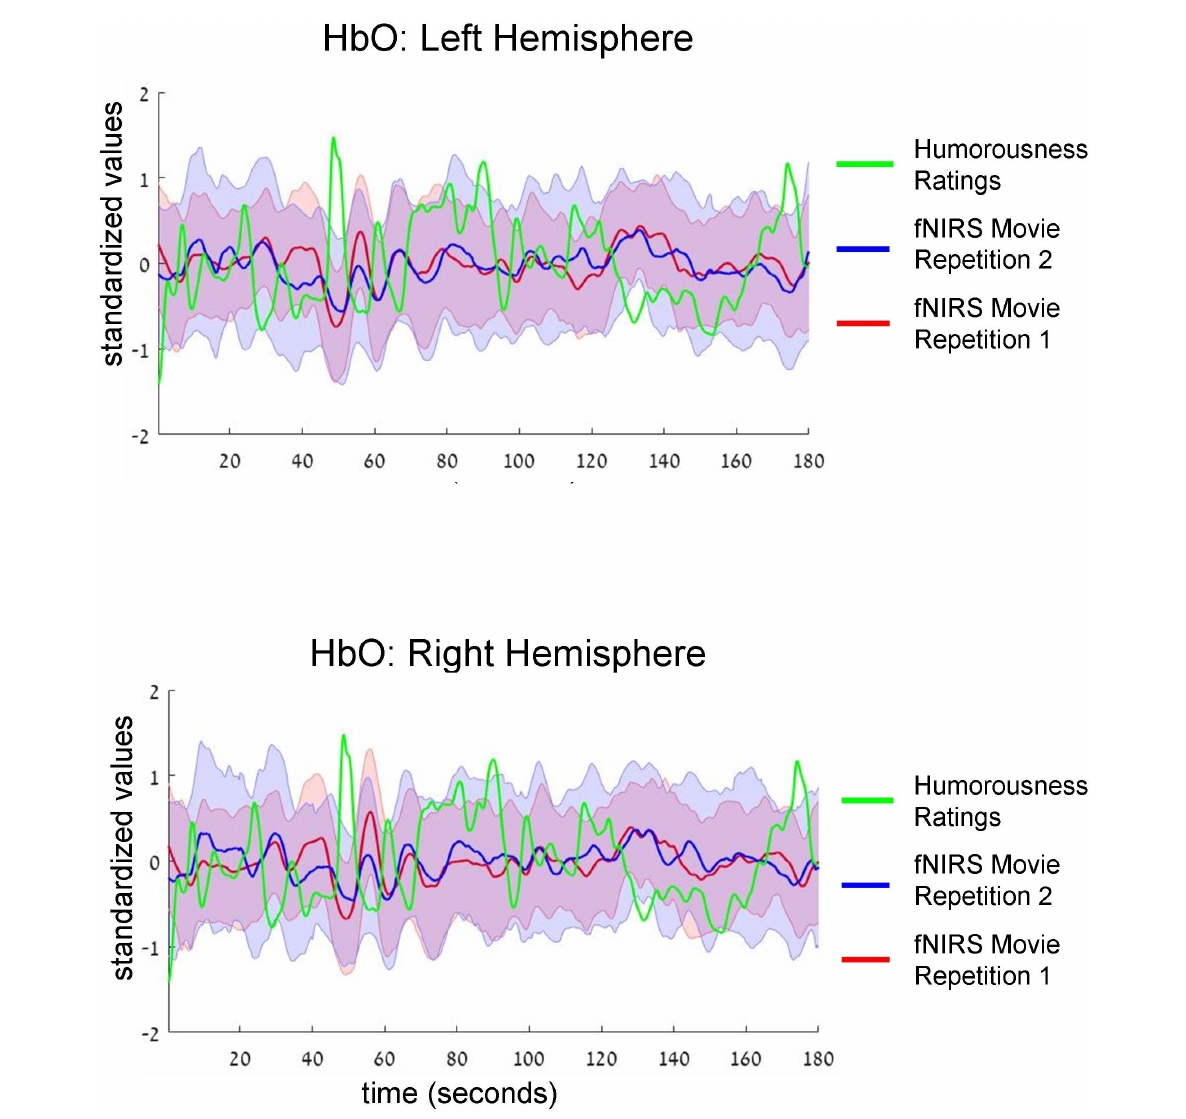
FIGURE3 Group-average time-courses of HbO fNIRS neural signals (i.e., two movie repetitions) and the ratings of humorousness of an independent group of participants. Top and bottom plots show fNIRS signals in the left and right hemispheres, respectively. Shadows around the fNIRS time-courses reflect standard error. For clarity of the figure, we do not show the standard deviation of the ratings of humorousness. Note negative correlation (i.e., anti-correlation) between neural signals and the ratings of humorousness. In addition, there is a correlation between the fNIRS signals of two repetitions of the